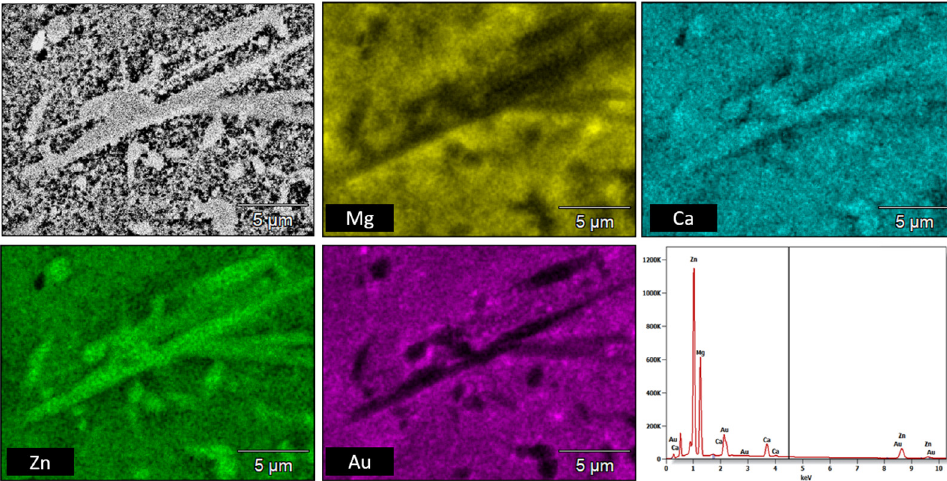
Materials 2023 , 16 , x FOR PEER REVIEW 11 of 17 Figure 7. EDS chemical composition map for the sintered sample of the Mg 63 Zn 30 Ca 4 Au 3 alloy. Figure 7. EDS chemical composition map for the sintered sample of the Mg 63 Zn 30 Ca 4 Au 3 alloy. Figure 7. EDS chemical composition map for the sintered sample of the Mg 63 Zn 30 Ca 4 Au 3 alloy.